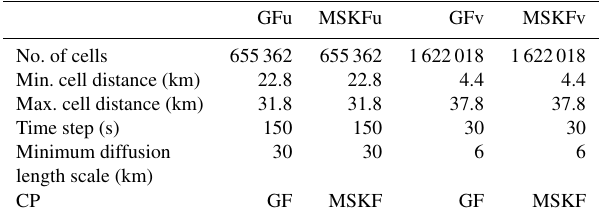
Table 1. Horizontal mesh resolution, minimum and maximum dis- tance between grid-cell centers, time step, horizontal diffusion length scale, and convective parameterization (CP) for numerical experiments with the uniform- and variable-resolution